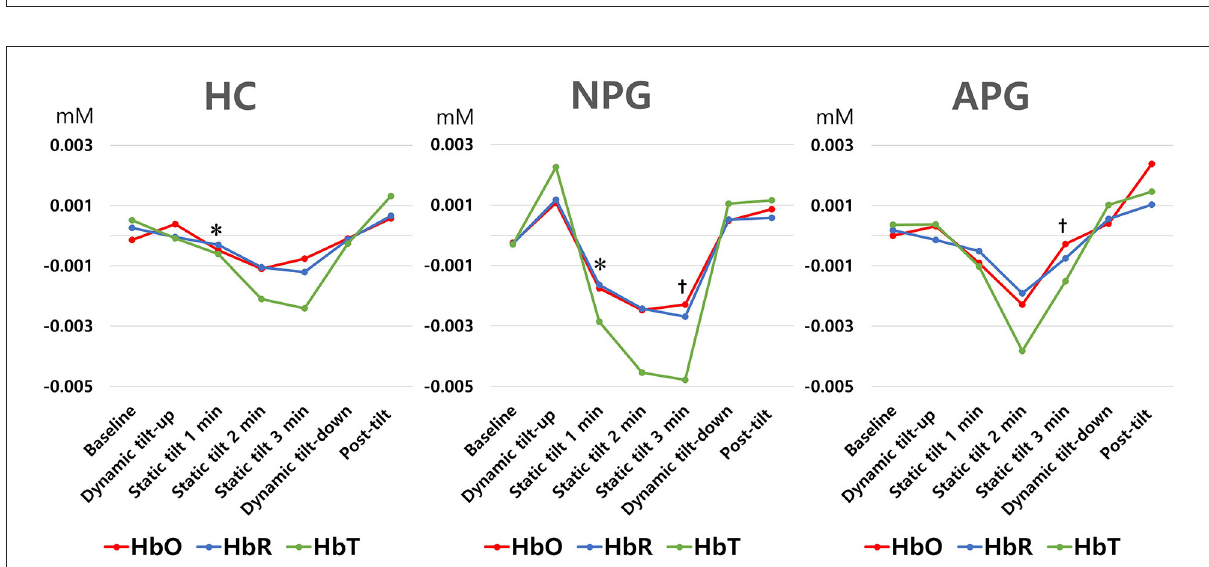
FIGURE6 Differences in HbO, HbR, and HbT concentrations are shown for each group at 1-min intervals during the static tilt phase. Statistically significant differences (p-value < 0.05) among groups are denoted by footnote (*, HC versus NPG in HbO, , NPG versus APG in HbO). HbR and